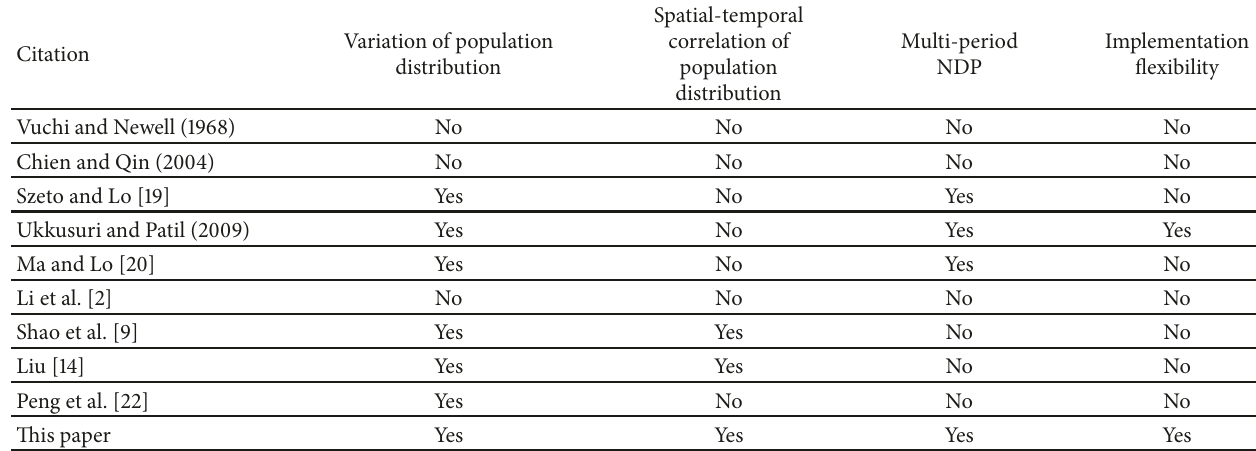
Table 1: Comparison between some closely concerned models with the model proposed in this paper.